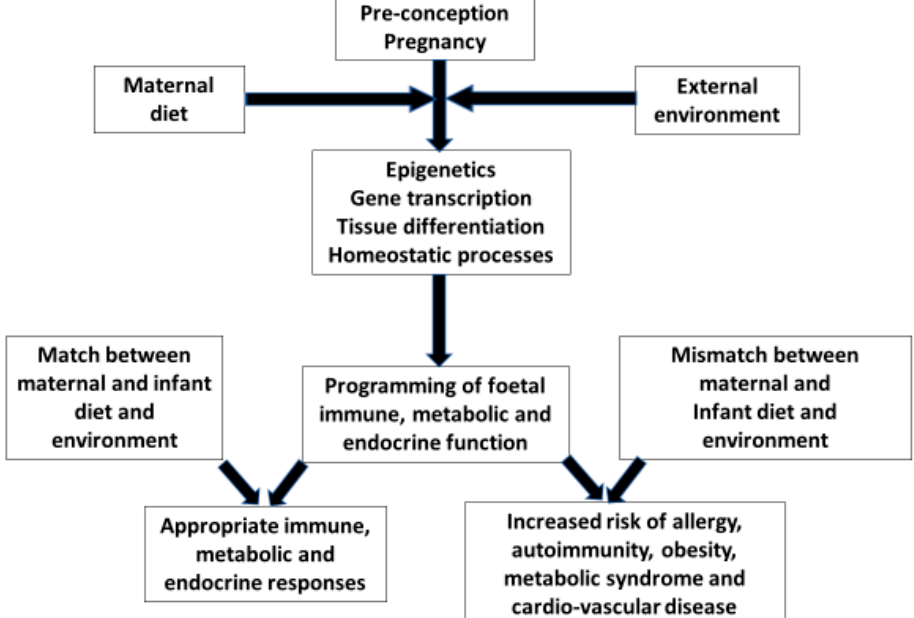
Figure 1. The evolutionary hypothesis based on Crespi BJ Front. Endocrinol. 2020 [2]. The pre-conception and pregnancy maternal gene/environment interactions are the mechanisms by which the foetus is prepared for extra-uterine life. If there is a mismatch between the maternal environment in her earlier life and that of her new-born, programming will be inappropriate for the infants’ environment. This will lead to endocrine, metabolic and immune responses which are ill-equipped to handle environmental exposures with increased risks of cardio-vascular disease, metabolic syndrome and non-communicable inflammatory diseases. Arrows indicate the direction of effect.